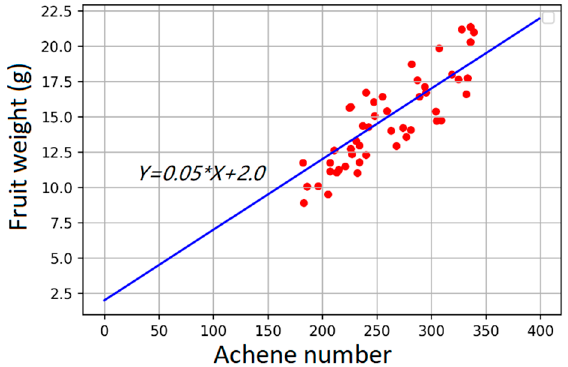
Figure 3. The blue line represents the fitted equation between the achene number in a berry and fruit weight in this simulation. The red dots represent the real strawberry berry information that we collected.